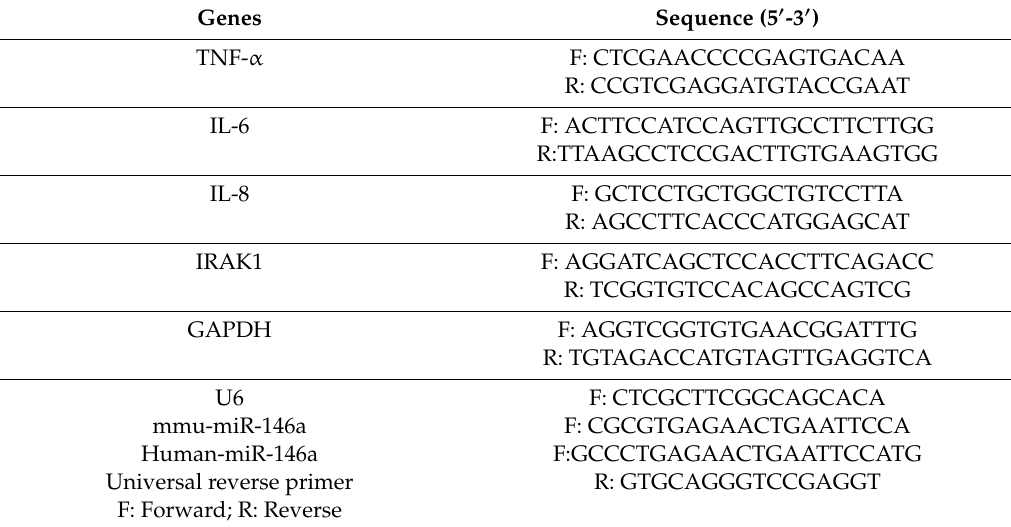
Table 1. Primers used for real-time quantitative PCR